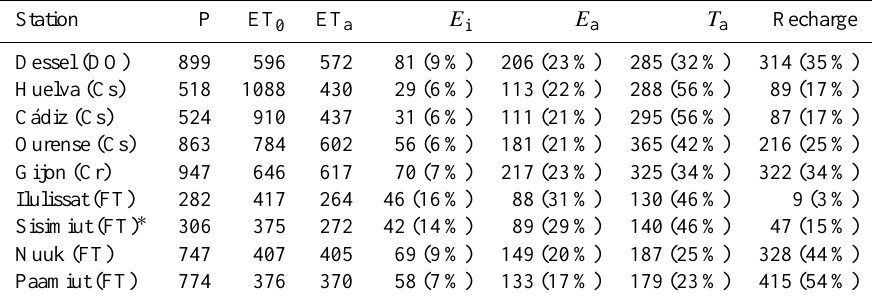
Table 3. Average annual precipitation ( P ), potential evapotranspiration (ET 0 ), actual evapotranspiration (ET a ), evaporation of intercepted water ( E i ), soil evaporation ( E a ), transpiration ( T a ) and groundwater recharge, in mmyr − 1 for Dessel and the 8 analogue stations. In parenthesis the percentage of precipitation is given for some